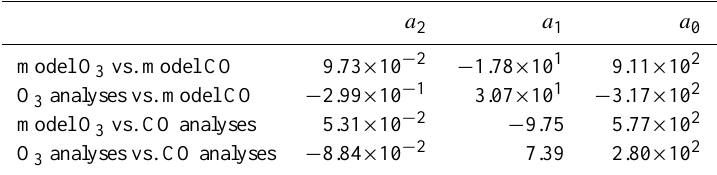
Table 1. Fitting coefficients for the ExTL of O 3 –CO correlations, assuming a quadratic form y = a 2 x 2 + a 1 x + a 0 . CO and O 3 values are defined by x and y ,